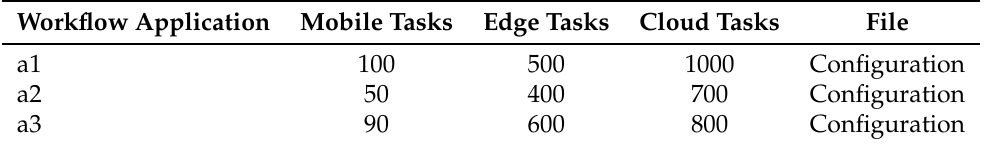
Table 4. Workflow